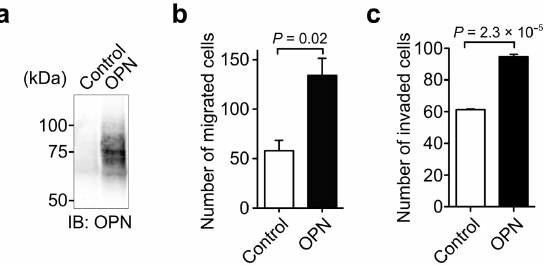
Figure 3. Effect of the forced expression of OPN in H358 cells on cell migration and invasion. ( a ) Expression of OPN in H358 transfectants. H358 cells with little OPN expression were transfected with either a control vector or OPN expression vector. The expression of OPN in the transfectants was confirmed by Western blot using anti-OPN polyclonal antibody (O-17). Unprocessed blot image is shown in Figure S2. Effect of OPN expression in H358 cells on cell migration ( b ) and invasion ( c ). Two-tailed unpaired Student’s t -test, mean ± SEM of three independent assays conducted in